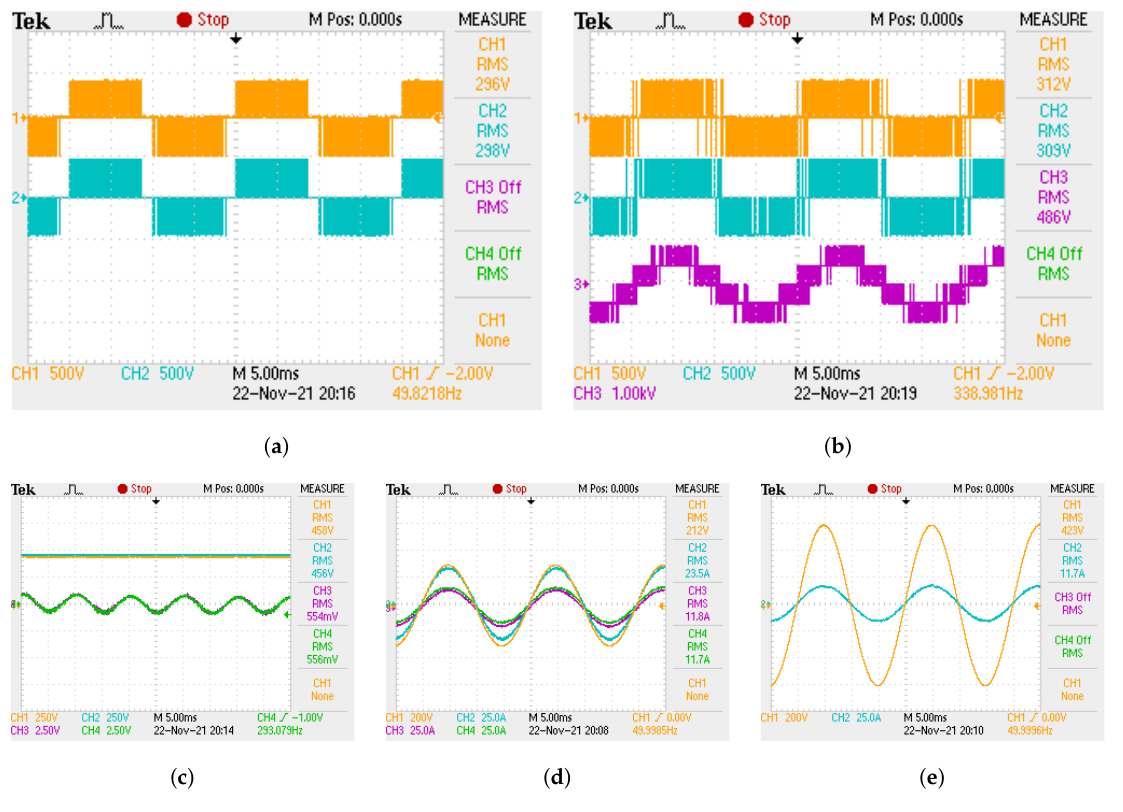
Figure 23. The 2-modules IPOS configuration experimental results: ( a ) primary side switching voltages, ( b ) secondary side switching voltages, ( c ) DC-links voltages, ( d ) primary side grid voltage and currents, ( e ) secondary side grid voltage and